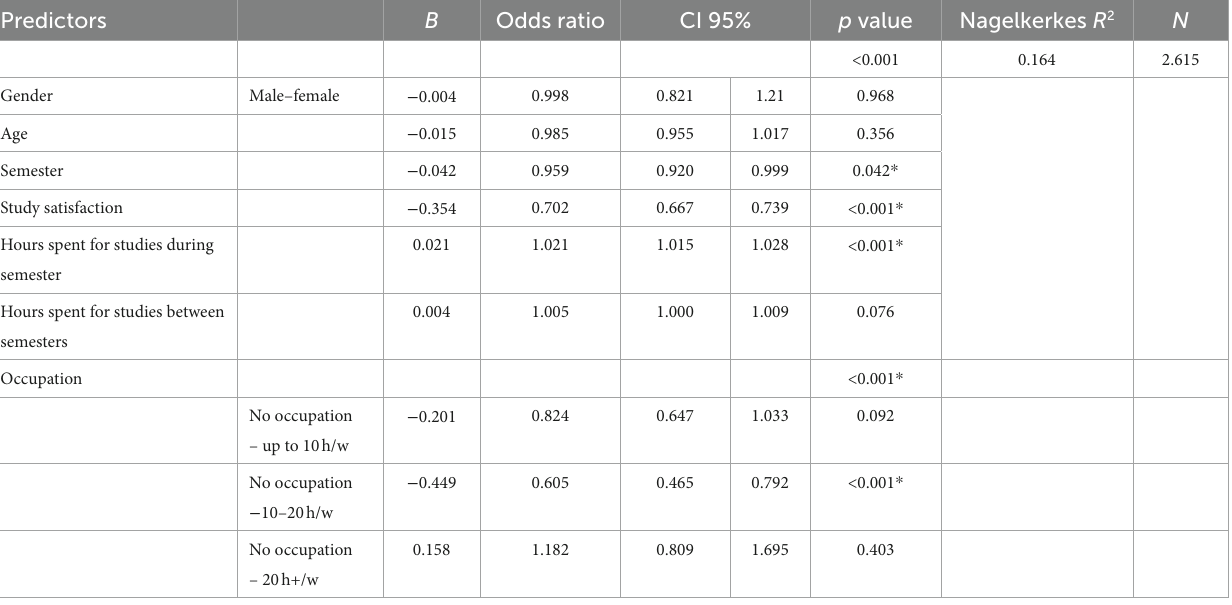
TABLE 4 Binary regression model for emotional